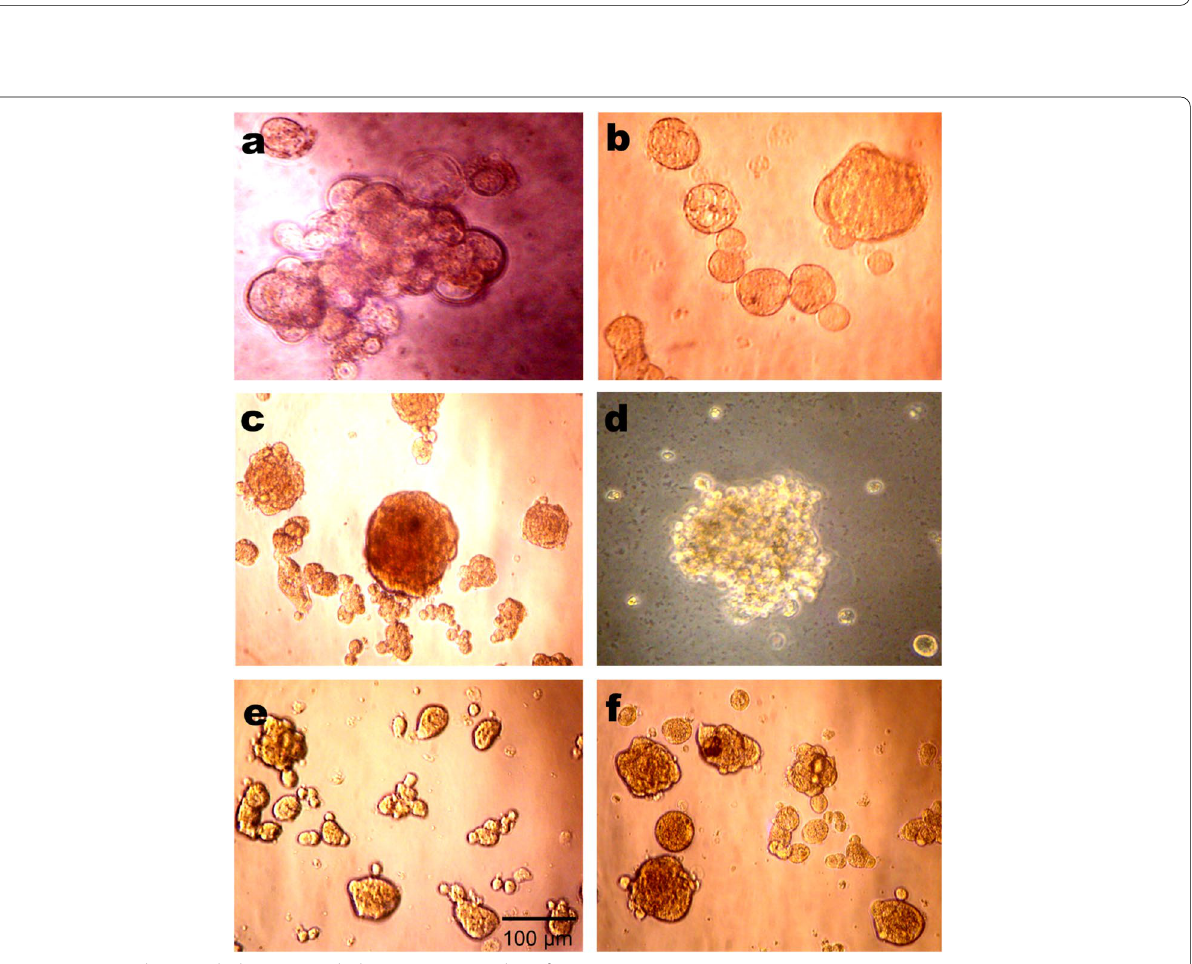
Fig. 3 Mammosphere-forming efficiency of stem-like cells isolated from normal breast tissues, primary tumor tissues, and MCF-7 cell line on days 7, 14, and 2